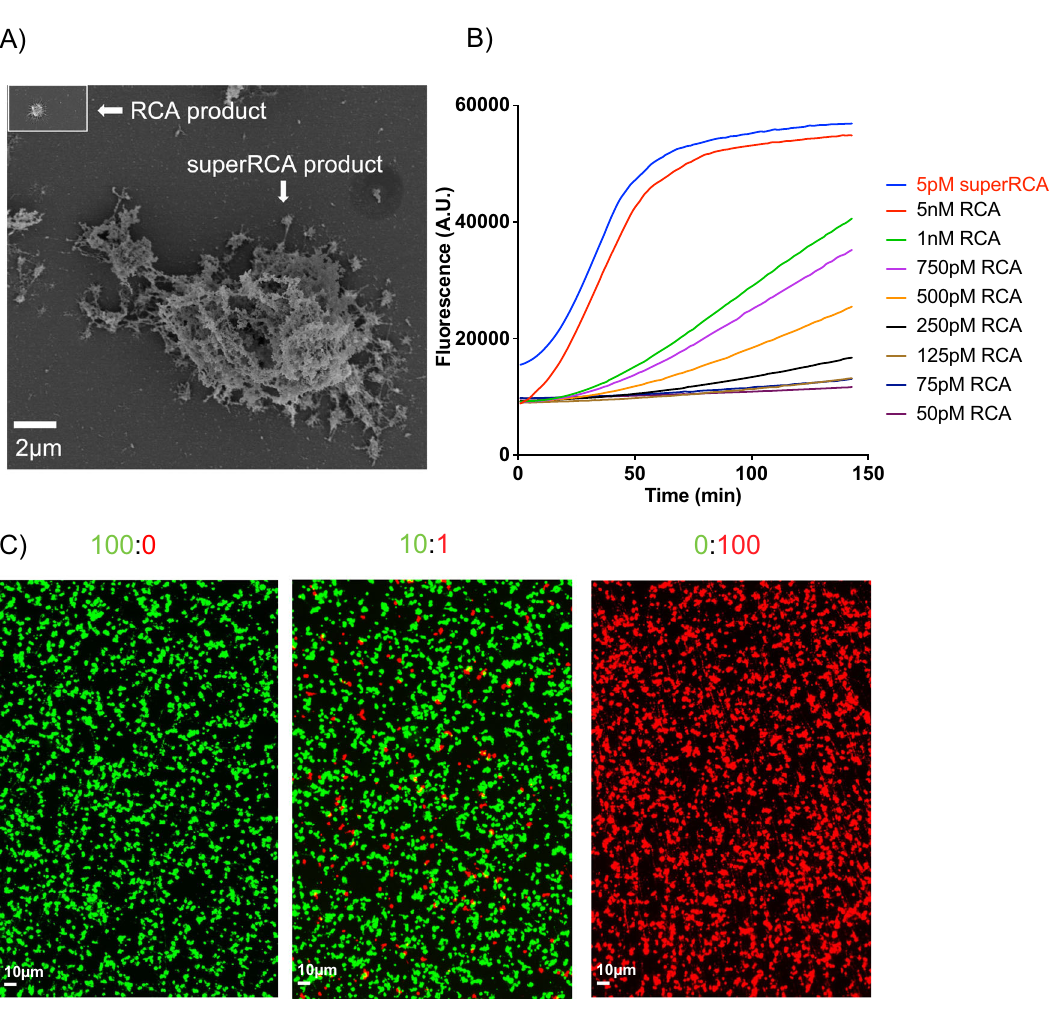
Fig. 2 Properties of superRCA reaction products. A Scanning electron micrographs illustrating the relative sizes of a fi rst-generation RCA product (inset) and a superRCA product having undergone two generations of RCA. B Real-time monitoring of fi rst- and second-generation RCA reactions illustrates the extent of ampli fi cation in each generation. RCA replication of 5 pM superRCA products, accumulate fl uorescence at the same rate as fi rst generation RCA products templated by 5 nM circularized padlock probes. The experiment demonstrates that the generation of monomer repeats during superRCA proceeds at a rate approximately 1000-fold faster than in a fi rst RCA, as evidence that each fi rst-generation DNA circle gives rise to around 1000 second- generation DNA circles. C Individual superRCA products, originating from single starting DNA circles as visualized by fl uorescence staining of products of three different reactions, starting from two DNA circles yielding green or red superRCA products in proportions of 1:0. 10:1, or 0:1. No mixed color products are observed, identifying these as digital